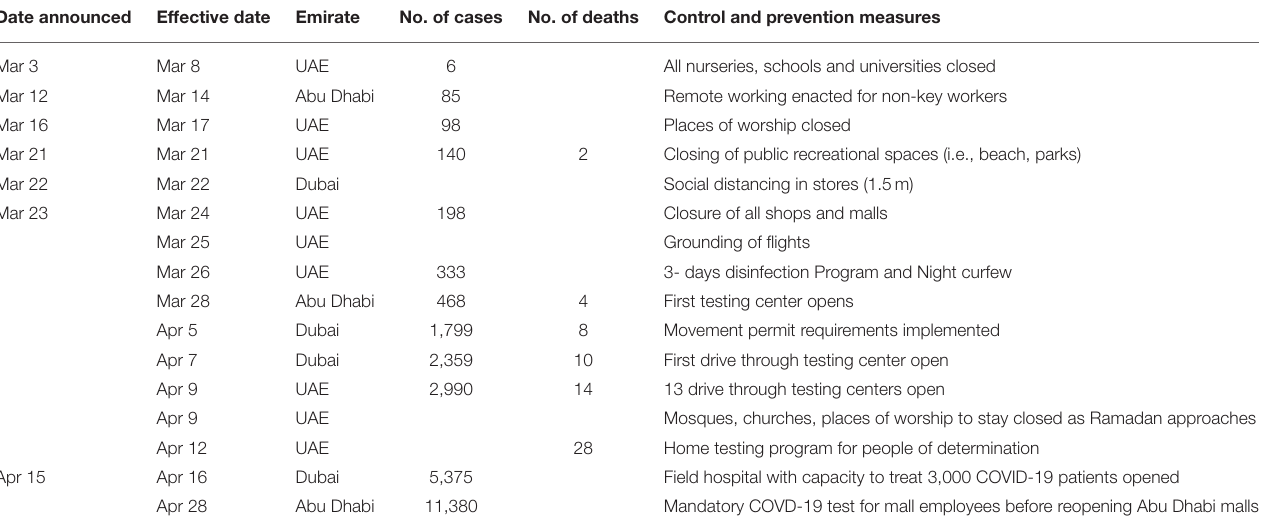
TABLE 1 | Timeline of the UAE’s COVID-19 key infection prevention and control